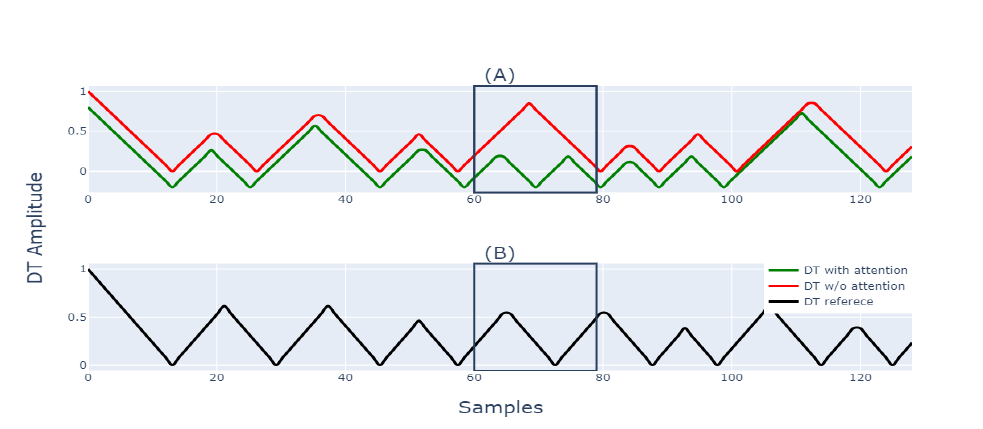
Figure 5. ( A ) shows the DT of respiration signal output with and without attention block; ( B ) shows the DT of reference respiration